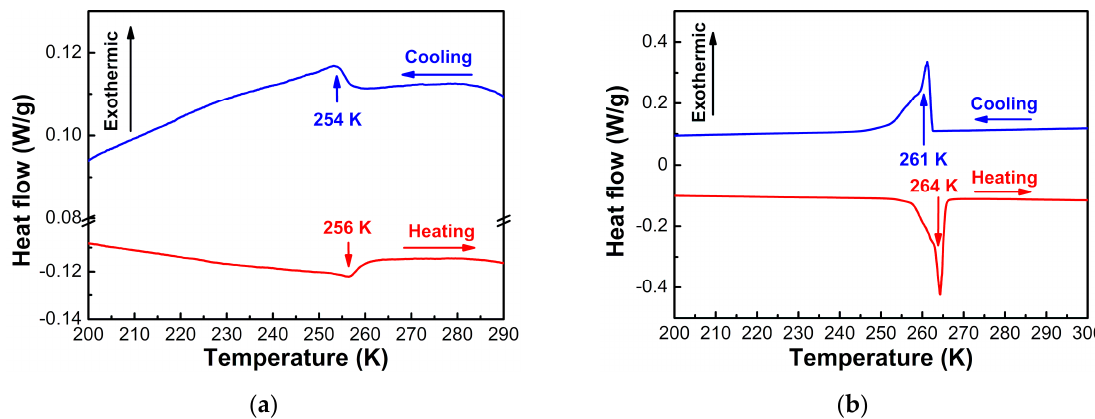
Figure 5. DSC curves of ( a ) [NH 4 ][Mg(HCOO) 3 ] and ( b ) [(CH 3 ) 2 NH 2 ][Mg(HCOO) 3 ] during cooling and heating processes at the rate of 5 K/min.